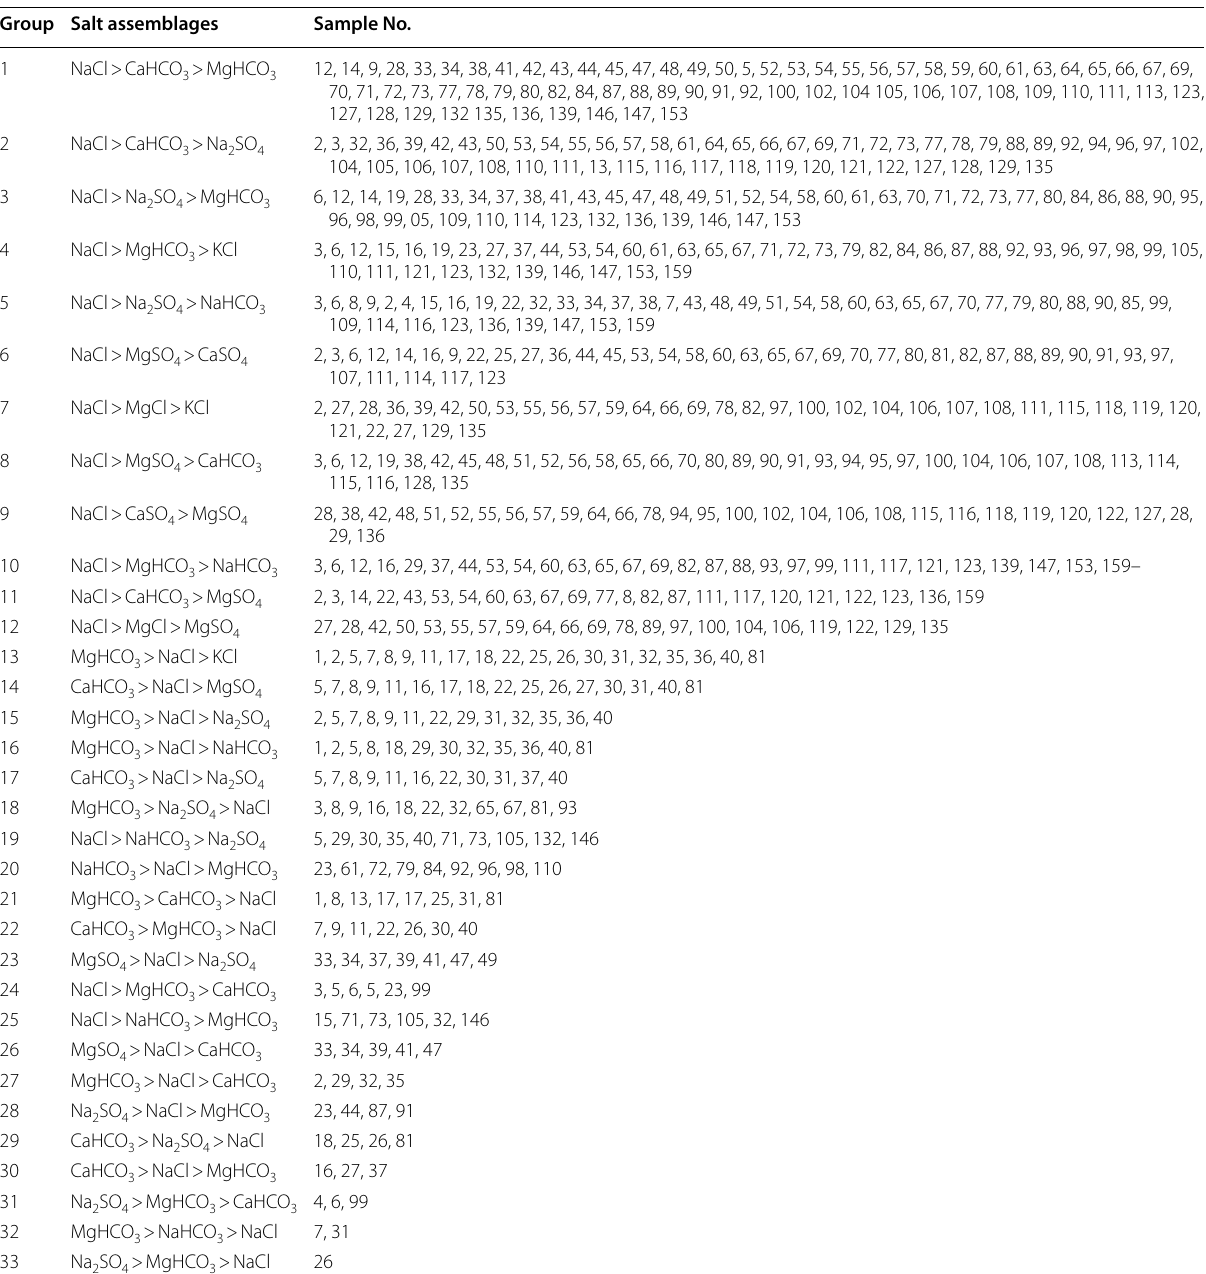
Table 6 Hypothetical salt combination groups of the obtained groundwater samples Group Salt assemblages Sample